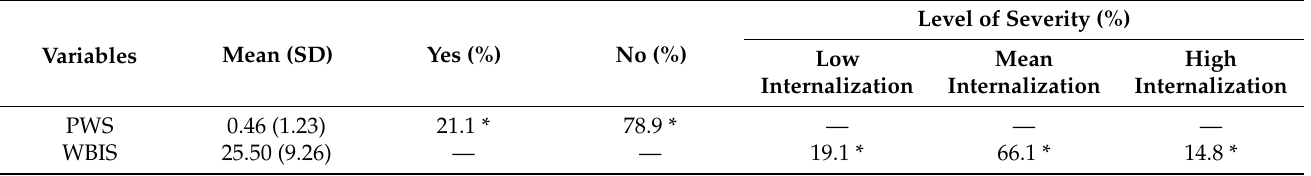
Table 2. Average Scores for Scales and Prevalence of Weight Stigma ( n =